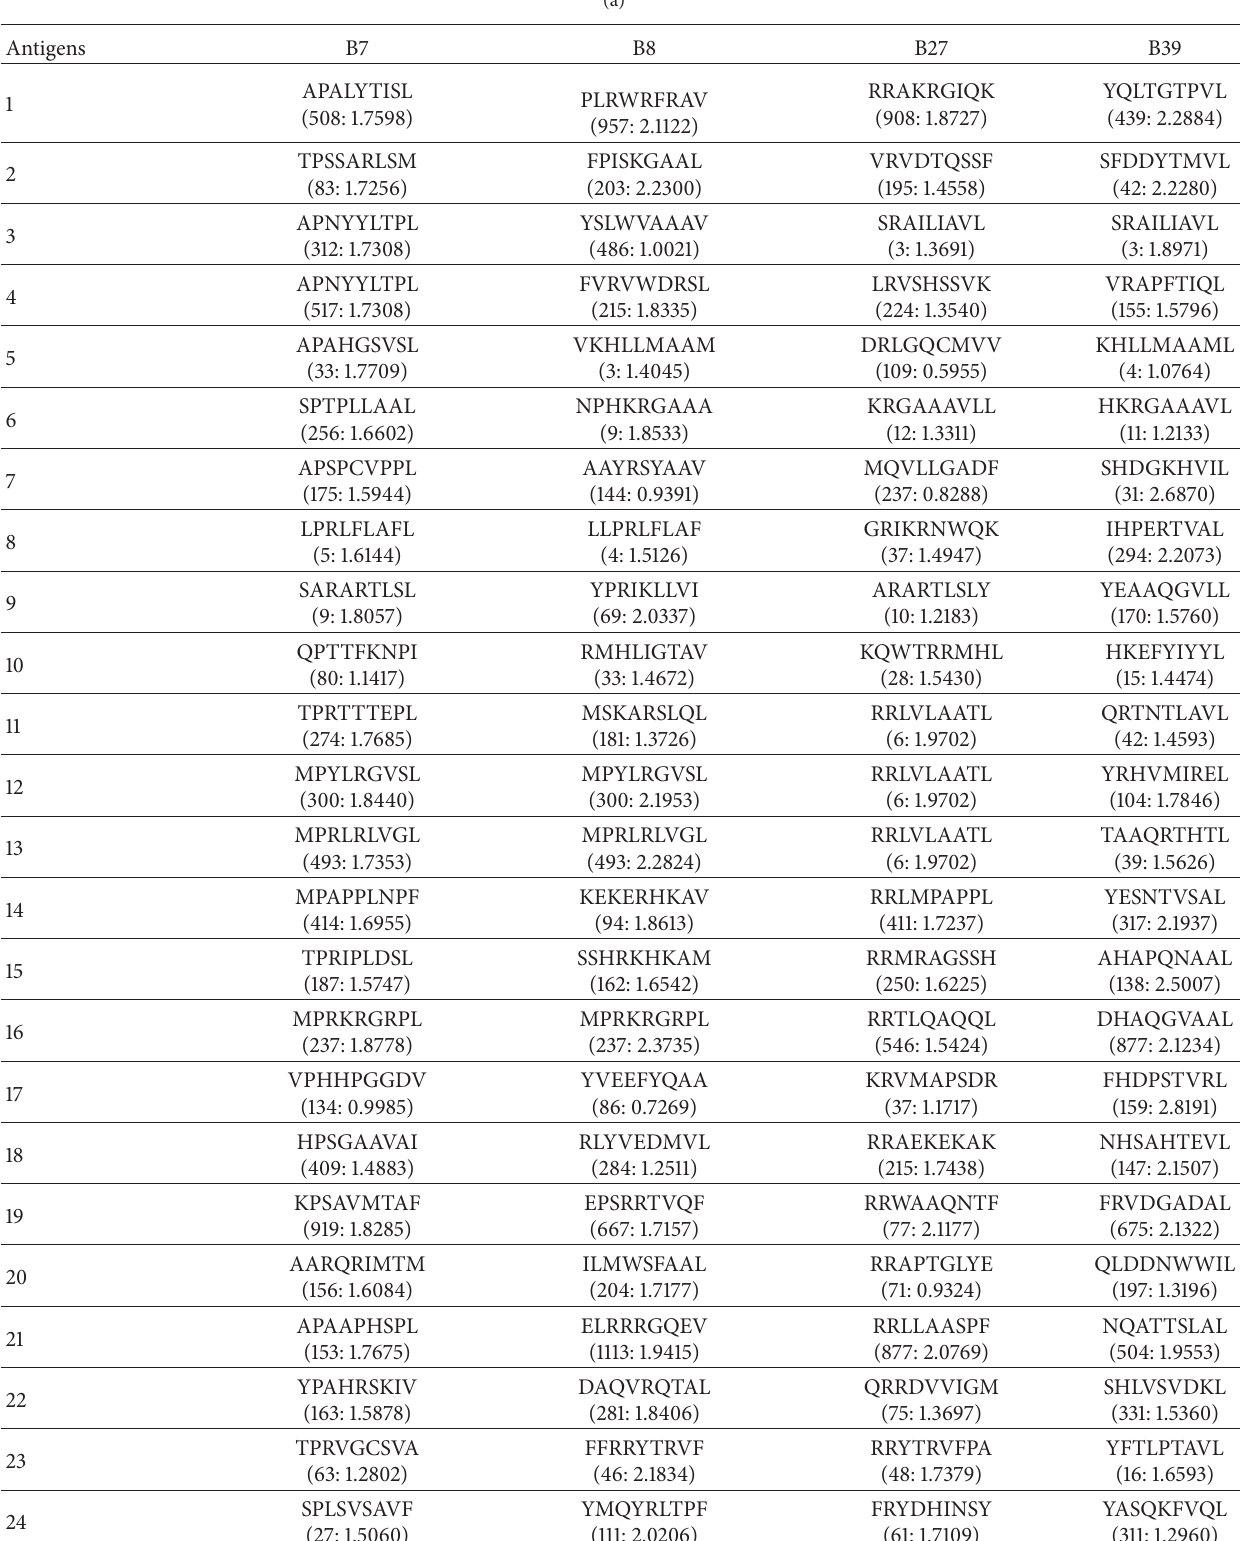
Table 3: (a) NetCTL predicted top scoring CTL epitopes along with start position and processing score for the HLA-B supertypes (B7, B8, B27, and B39) in 25 L. major candidate antigens. (b) NetCTL predicted top scoring CTL epitopes along with start position and processing score for the HLA-B supertypes (B44, B58, and B62) in 25 L. major candidate